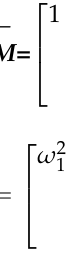
Figure 5. The disturbance force and tongue of RWA. ( a ) F x ; ( b ) F y ; ( c ) F z ; ( d ) M x ; ( e ) M y ; ( f ) M z . By doing so, the mass, stiffness, and damping matrices are diagonalized. The